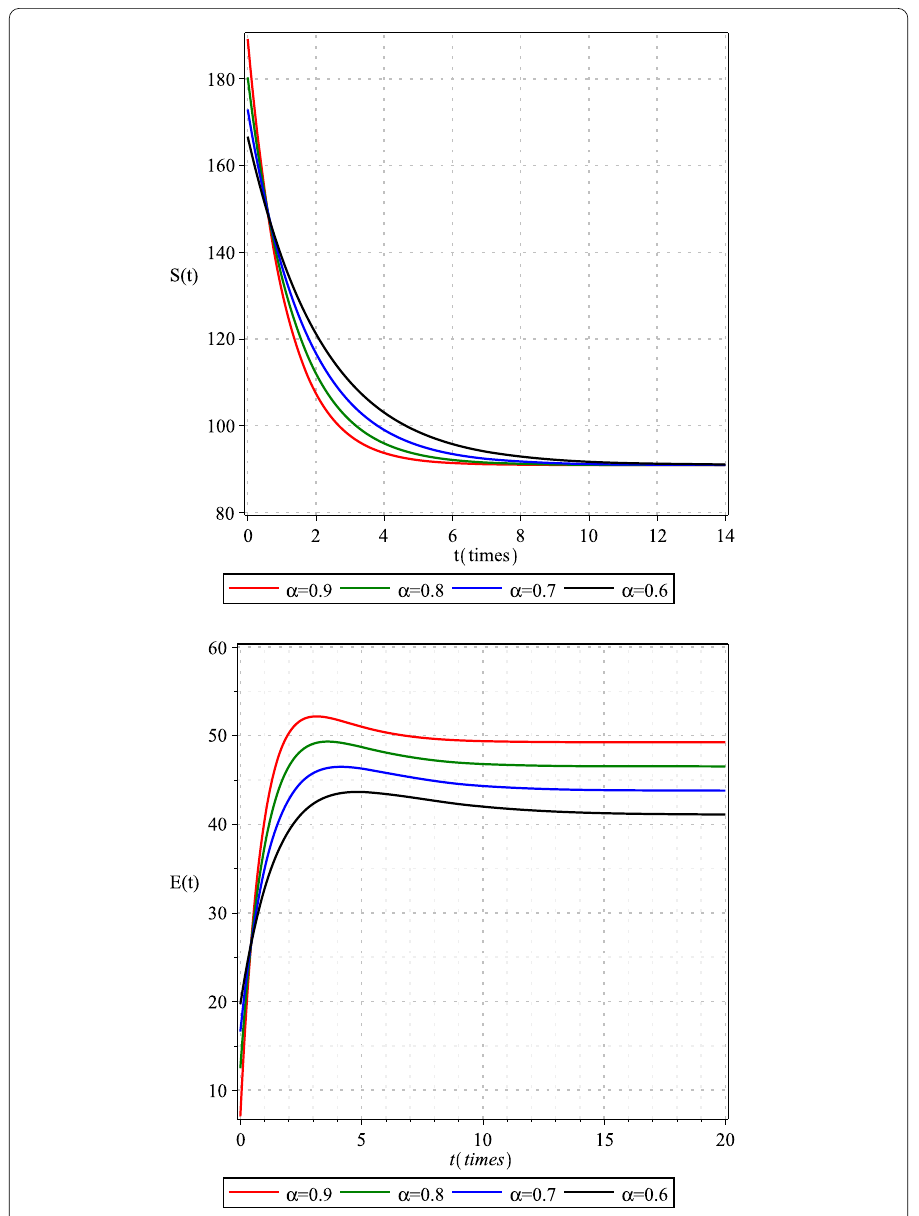
Figure 2 Plots of susceptible parameter S ( t ) and latent parameter E ( t ) corresponding to different values of α = 0.9,0.8,0.7,0.6